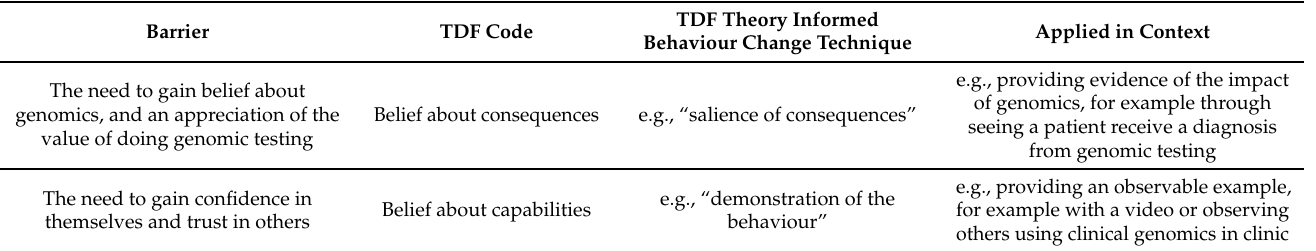
Table 5. Examples of applying behaviour change theory in practice.